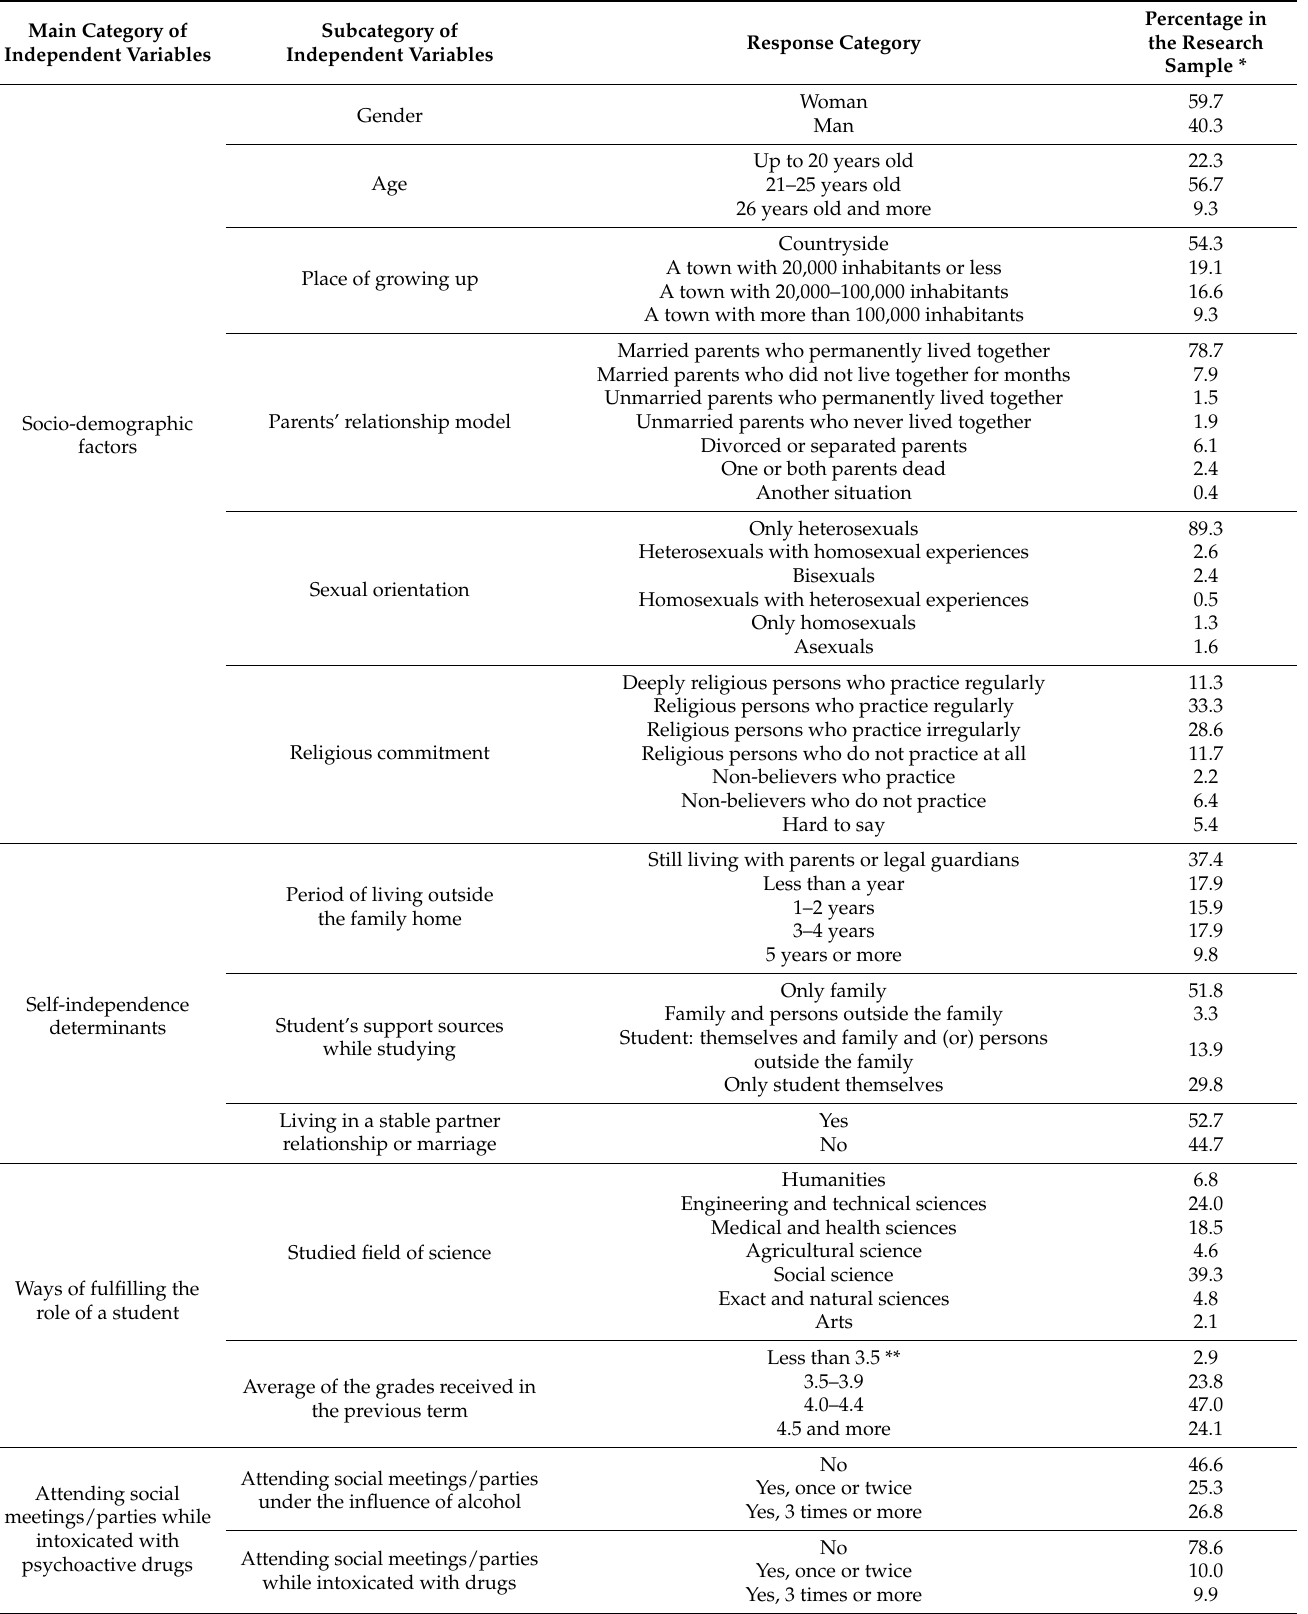
Table 1. Characteristics of the research sample, n =